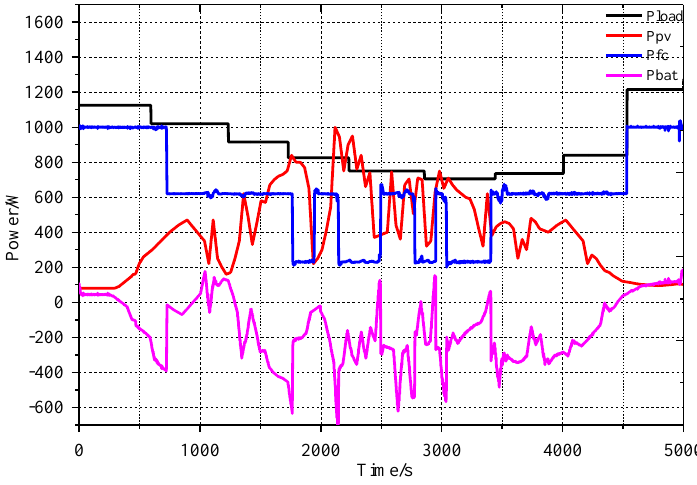
Figure 9. Power flow of the DC microgrid with initial SOC at 25%.